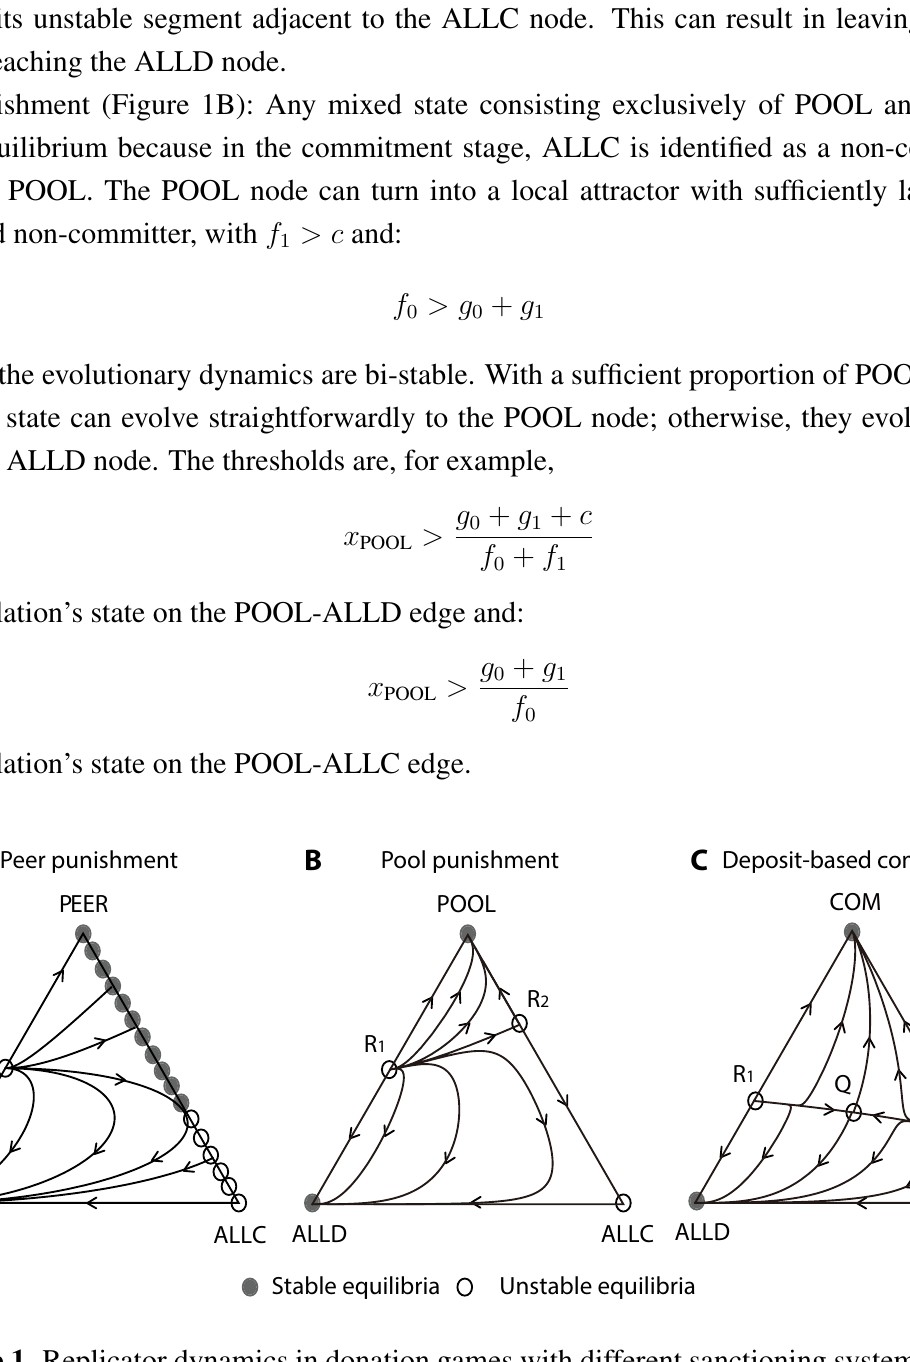
Figure 1. Replicator dynamics in donation games with different sanctioning systems. ( A ) In peer punishment, with its small perturbation and neutral drift around the PEER-ALLC edge, the population’s state eventually converges to the ALLD node; ( B ) in pool punishment, the POOL-ALLC edge no longer consists of a continuum of equilibria, and instead, the POOL node turns into a local attractor; ( C ) in deposit-based commitment, the basin of attraction for the homogeneous state of punishers is broader than that in peer and pool punishment. For specific parameters, the interior state space can have a unique equilibrium Q that is a saddle = 3 , g = 1 , f = 3 and g = 1 point. Parameters: b = 3 , c = 1 , f 0 0 1 1